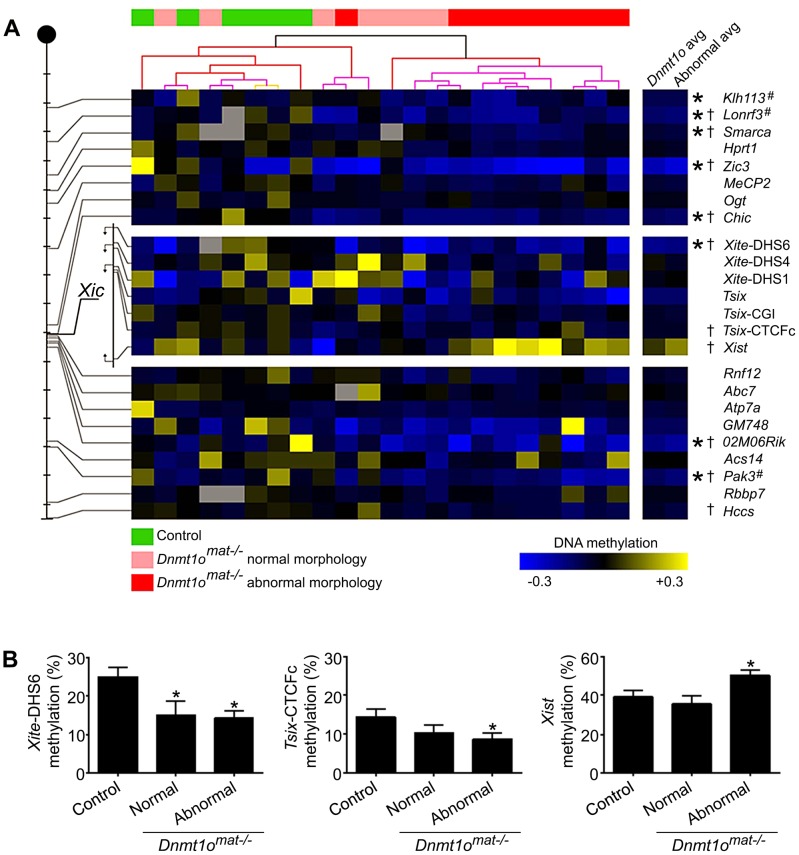
DNA methylation of X-CGI and Xic loci in Dnmt1omat−/− female placentae.(A) Analysis of X-CGI and Xic loci in Dnmt1omat−/− female placentae using MassARRAY. The positions of 17 CpG islands and 7 regions of the Xic that were analysed are depicted on the left of the figure. Each tick mark equals 10 Mb. Methylation values are displayed relative to the average of the control samples for each gene (blue, hypomethylation; yellow, hypermethylation). Samples are clustered according to their methylation values revealing two distinct groups (green, control; pink, Dnmt1omat−/− normal morphology; red, Dnmt1omat−/− abnormal morphology). (*p<0.05 control versus Dnmt1omat−/−; †p<0.05 control versus Dnmt1omat−/− abnormal morphology). Loci marked with “#” were identified through RLGS experiments. (B) Histograms displaying the absolute methylation values for Xite-DHS6, Tsix-CTCFc and Xist genes separated into placenta morphology groups (*p<0.05 control versus normal or abnormal Dnmt1omat−/−).